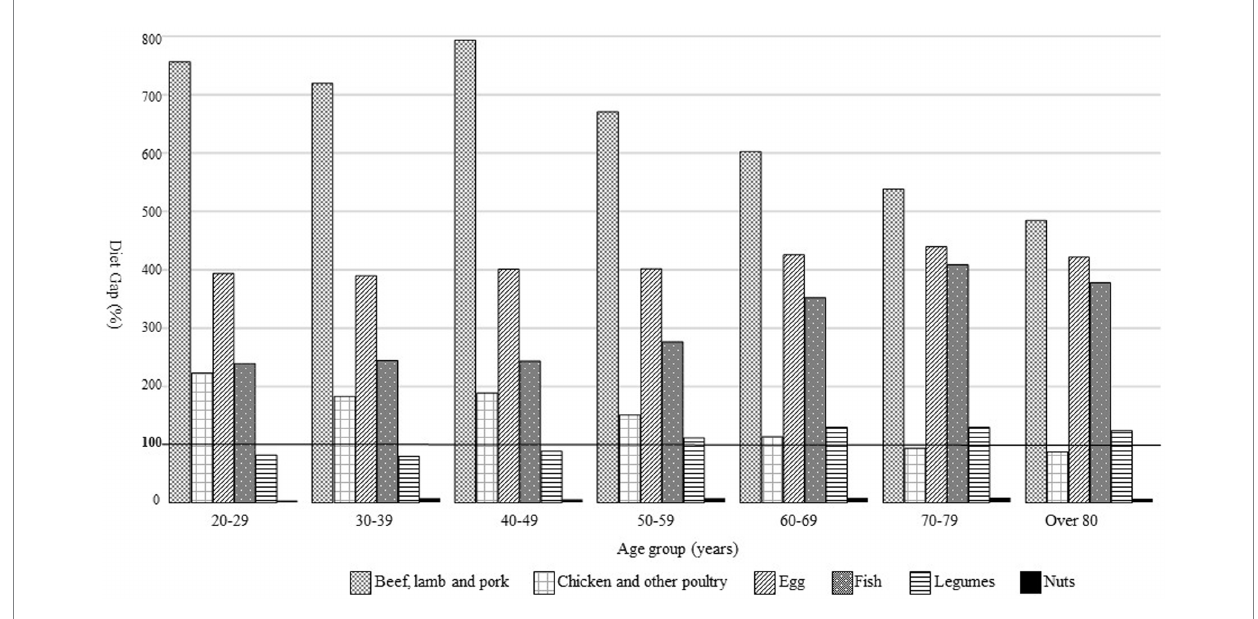
FIGURE 1 The diet gap between current intakes of protein food in the Planetary Health Diet by age